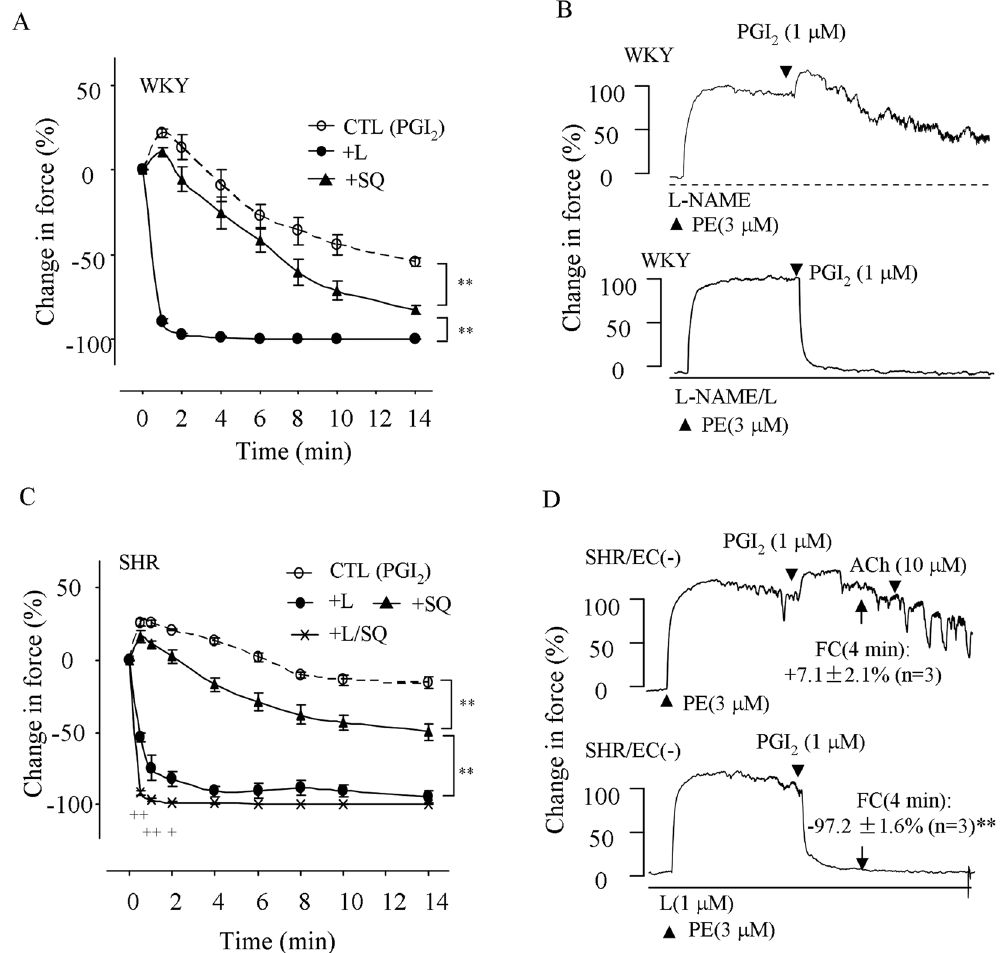
Figure 2. Effect of TP and/or EP3 antagonism in PE-precontracted, NOS-inhibited or endothelium-denuded rat mesenteric resistance arteries. ( A ) The control response evoked by PGI 2 (1 μ M; CTL) in L-NAME-treated WKY vessels precontracted with PE (3 μ M) and that obtained with the EP3 antagonist L798106 (1 μ M; + L; bottom) or the TP antagonist SQ29548 ( + SQ; 10 μ M). ( B ) Representative traces showing the response evoked by PGI 2 (top) and that obtained with L798106 (1 μ M; + L; bottom) in ( A ). ( C ) The control response evoked by PGI 2 in PE-precontracted, L-NAME-treated SHR vessels and that obtained with SQ29548 ( + SQ), with L798106 ( + L), or with L798106 and SQ29548 ( + L/SQ). In A and C, n = 5 for each; ** P < 0.01; + P < 0.05 and ++ P < 0.01 vs. the value in + L. ( D ) Representative traces with summarized values showing the control response evoked by PGI 2 (top) in PE-precontracted, endothelium-denuded SHR vessels (top) and that obtained with L798106 ( + L; bottom). FC (4 min): the value of force change relative to that of PE 4 min after the application of PGI 2 . ** P <